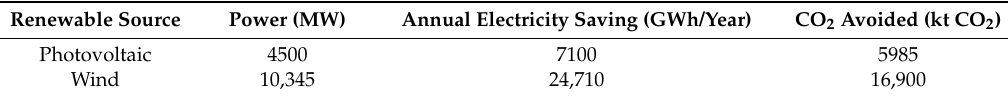
Table 1. Renewable potentials in Sicily.